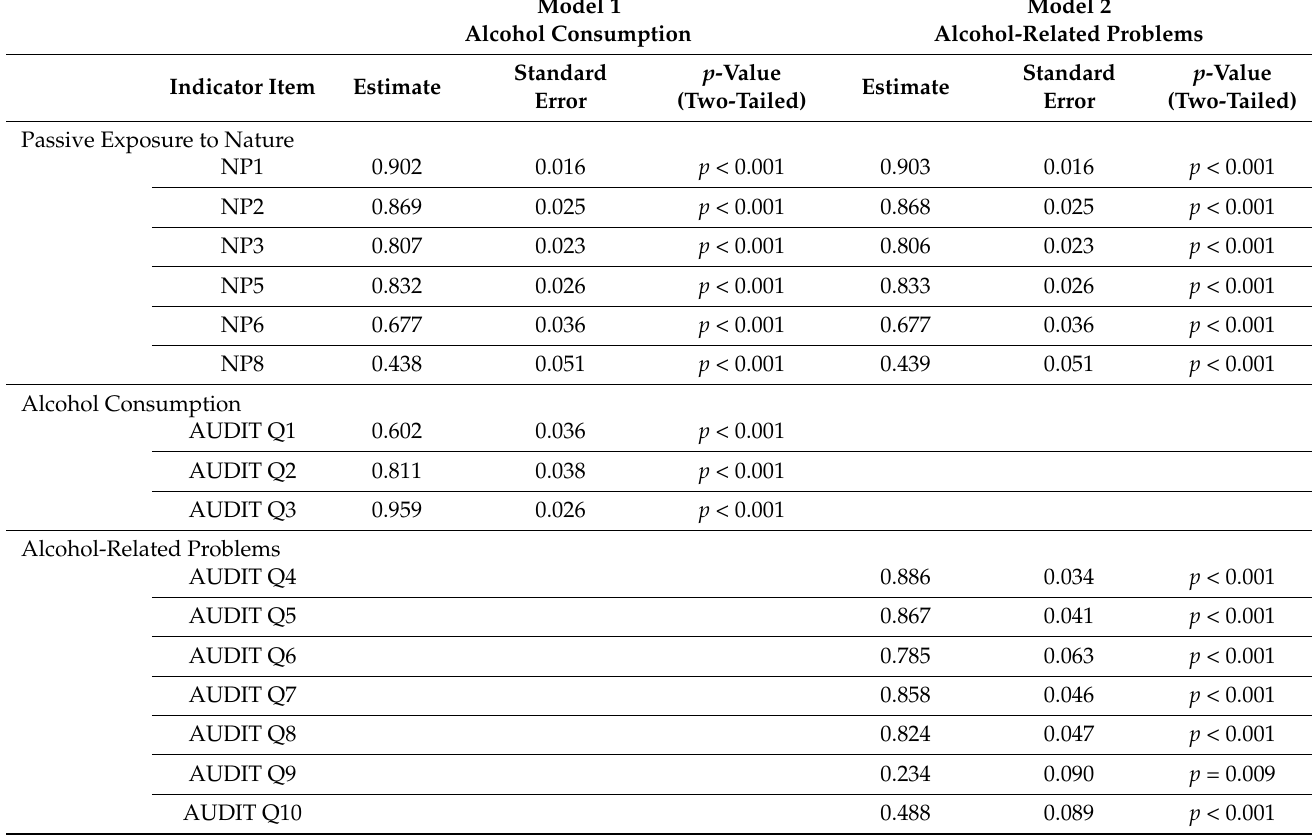
Table 2. The standardized estimates, standard errors, and p -values of indicators of the latent variables in both models. Model 1 Model